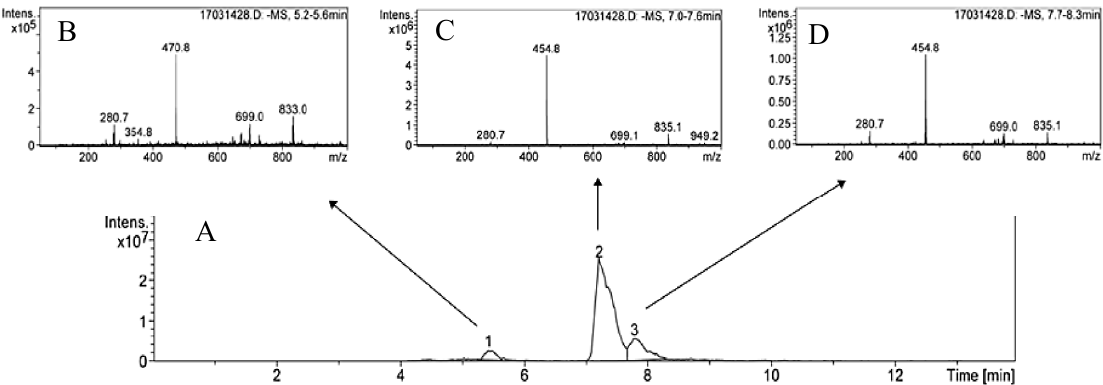
Figure 4. Chromatograms obtained after reverse phase HPLC-UV / vis (Panel ( A )) and HPLC-MS (Panel ( B – D )) analysis of root olive tree triterpenic extracts. Compound 1—maslinic acid, 2—betulinic acid, 3—oleanolic acid.